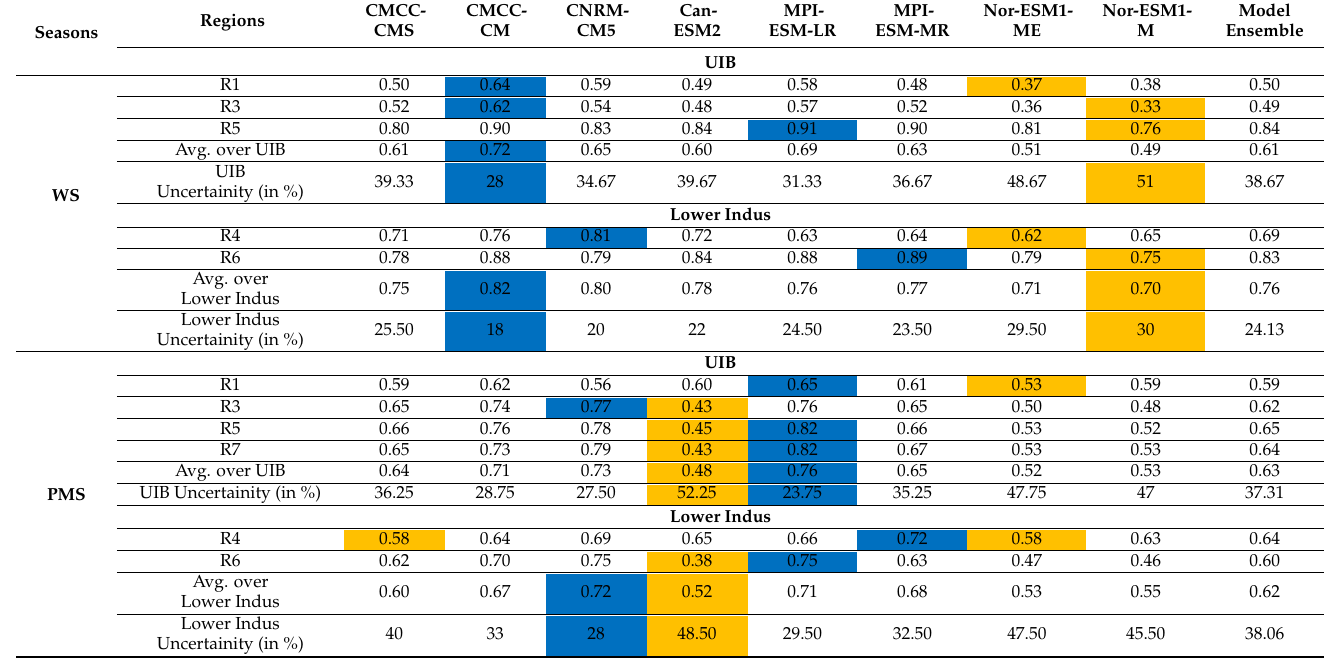
Table 4. Same as Table 3, but showing General Circulation Model (GCM) uncertainties for T max predictors. Here the ERA- Interim predictors were individually compared with the corresponding GCM simulated predictors during the overlapping historical period 1979–2005 to compute weighted PS. The last column shows the ensemble performance over various scales. Blue (orange) marks indicate the best (worst) GCM according to the highest (lowest) weighted PS. Seasons